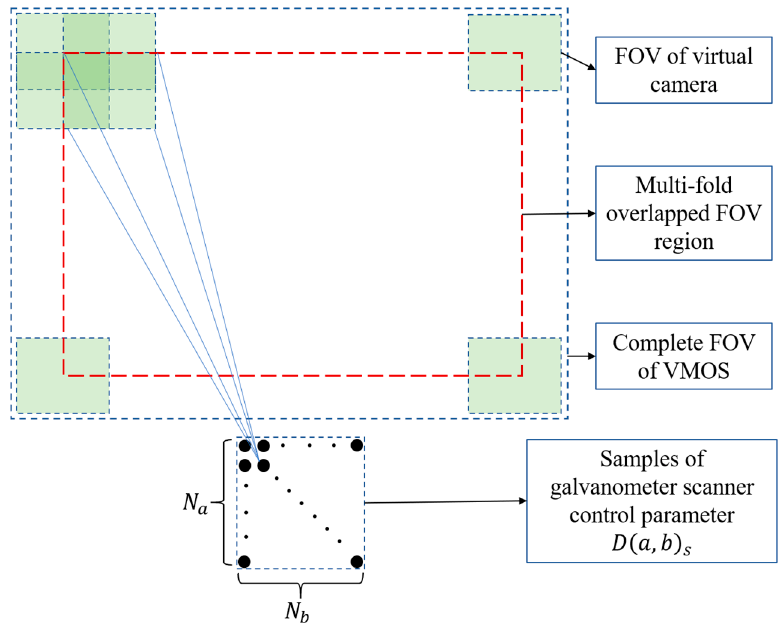
Figure 4. The control parameter samples and the virtual cameras’ overlapped FOVs.